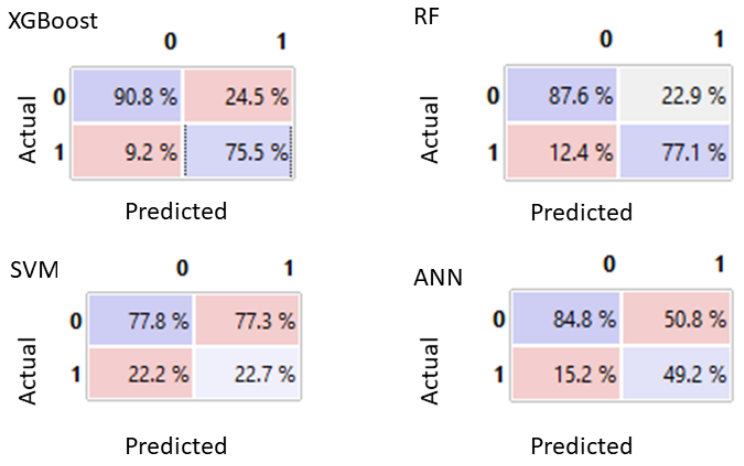
Figure 10. Confusion matrices of four